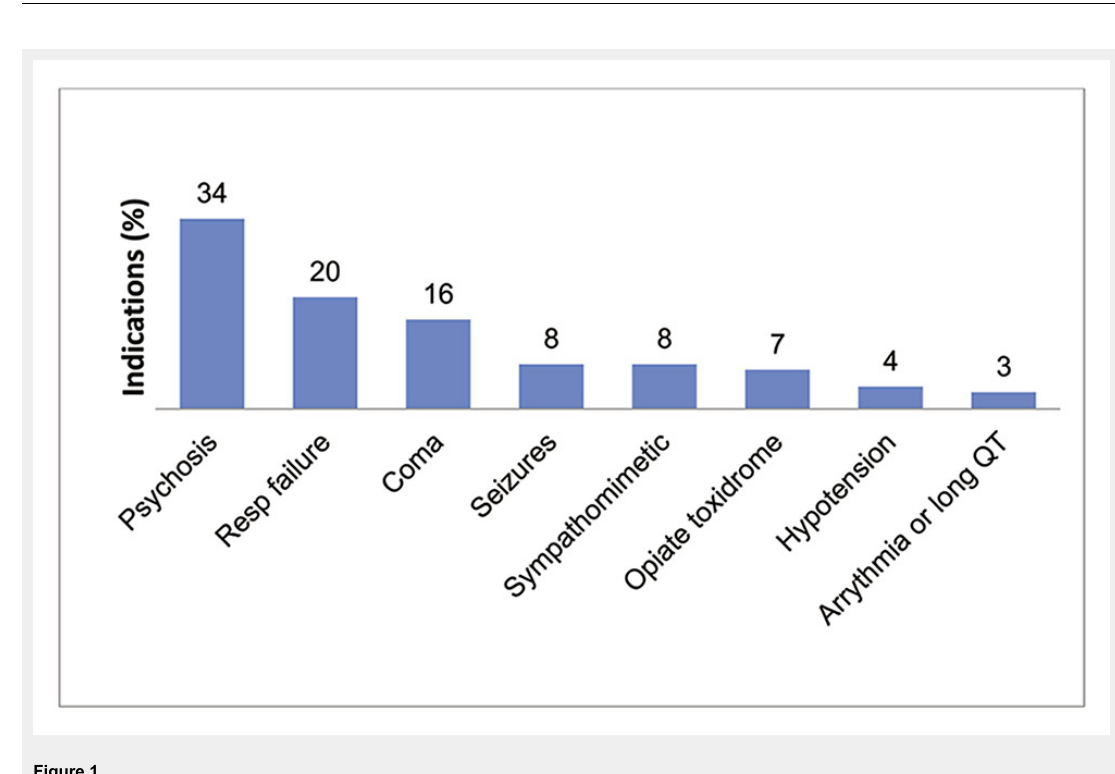
Figure 1 Indications for urinary drug screening (n = 369) in 262 patients. Arrhythmia or long QT = QT prolongation >480 ms, or ventricular tachycardia or flutter, or torsade de pointes tachycardia; Hypotension = systolic hypotension (<80 mm Hg); Opiate toxidrome = if requiring antagonist administration; Psychosis = first psychotic episode; Resp failure = acute respiratory failure (pCO 2 45–80 mm Hg or emergency intubation); Sympathomimetic = clinical signs of sympathomimetic